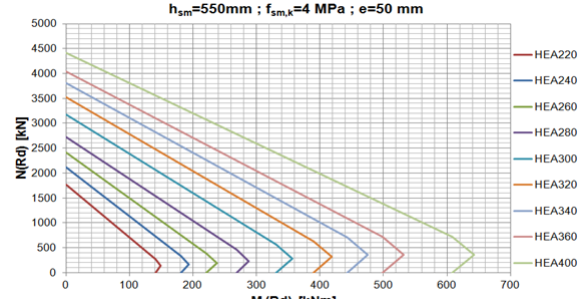
Figure 6. Interaction diagram for the design of a temporary soil mix panel (thickness 55 cm) reinforced with steel beams (type HEA – steel grade S235) for a UCS characteristic value of 4 MPa for the soil mix material and an execution tolerance of 5 cm for the positioning of the steel beam, according to [22,